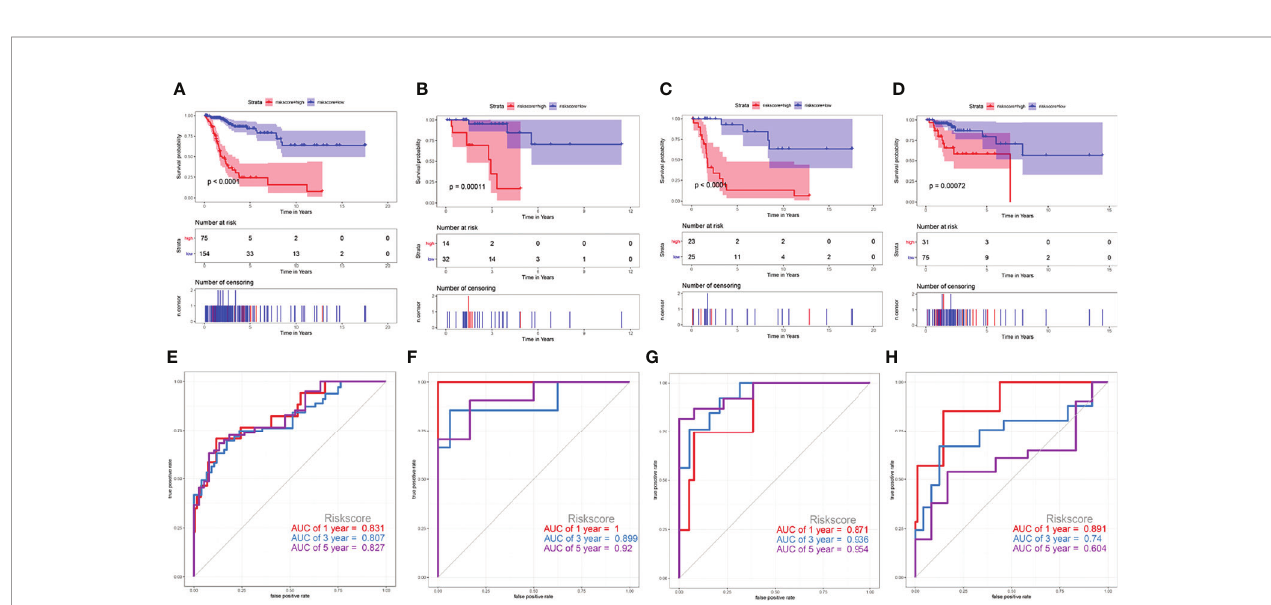
FIGURE 9 | Validate the prediction ef fi ciency of the risk score signature in different subtypes of cervical cancer. (A, E) squamous cell neoplasms, (B, F) non- squamous cell neoplasms, (C, G) keratinizing squamous cell carcinoma, (D, H) non-keratinizing squamous cell